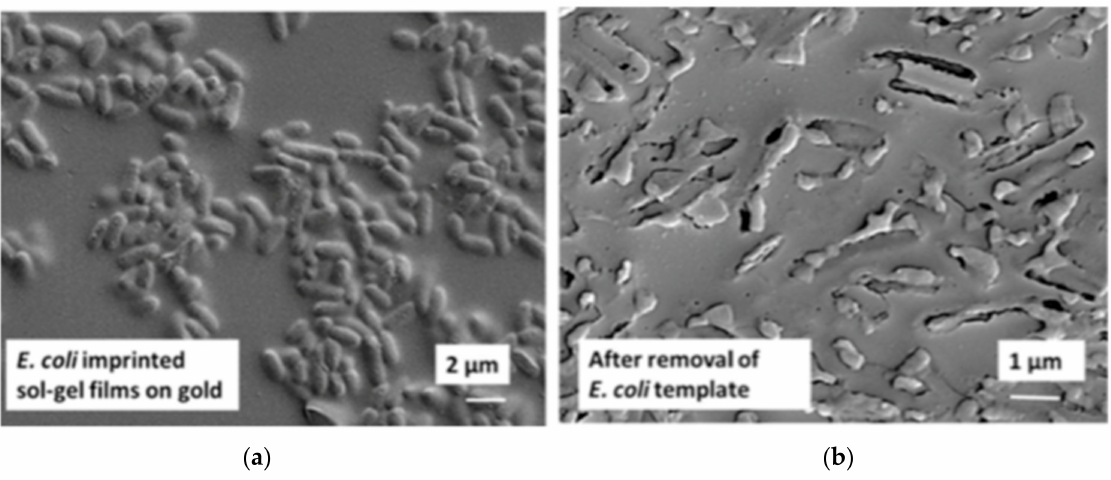
Figure 21. SEM images of E.coli imprinting before ( a ) and after removal ( b ) of templates. Reproduced with permission of Elsevier from [137].